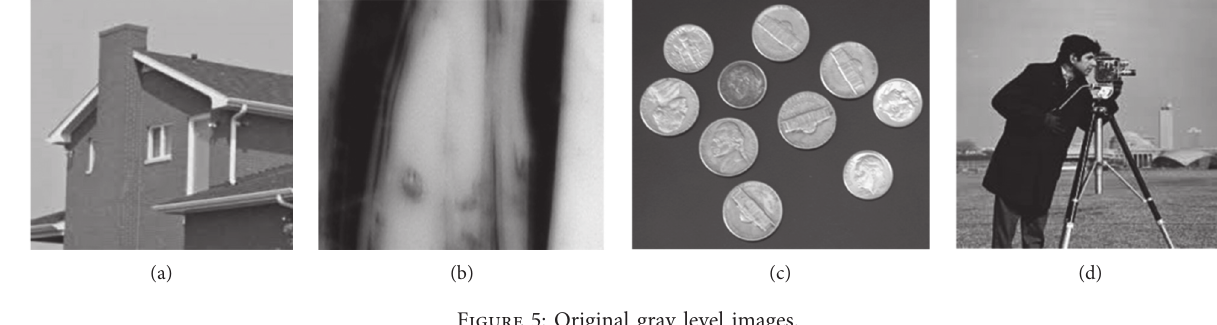
Figure 5: Original gray level images. Table 1: Comparison between the proposed global thresholding and Otsu’s method. Proposed global